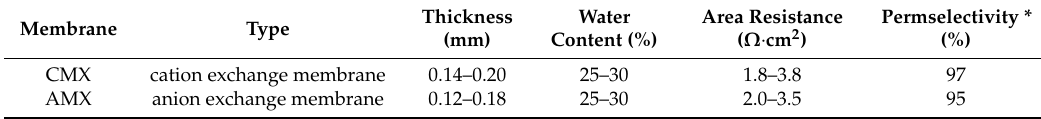
Table 1. Physicochemical characterization of the CMX and AMX